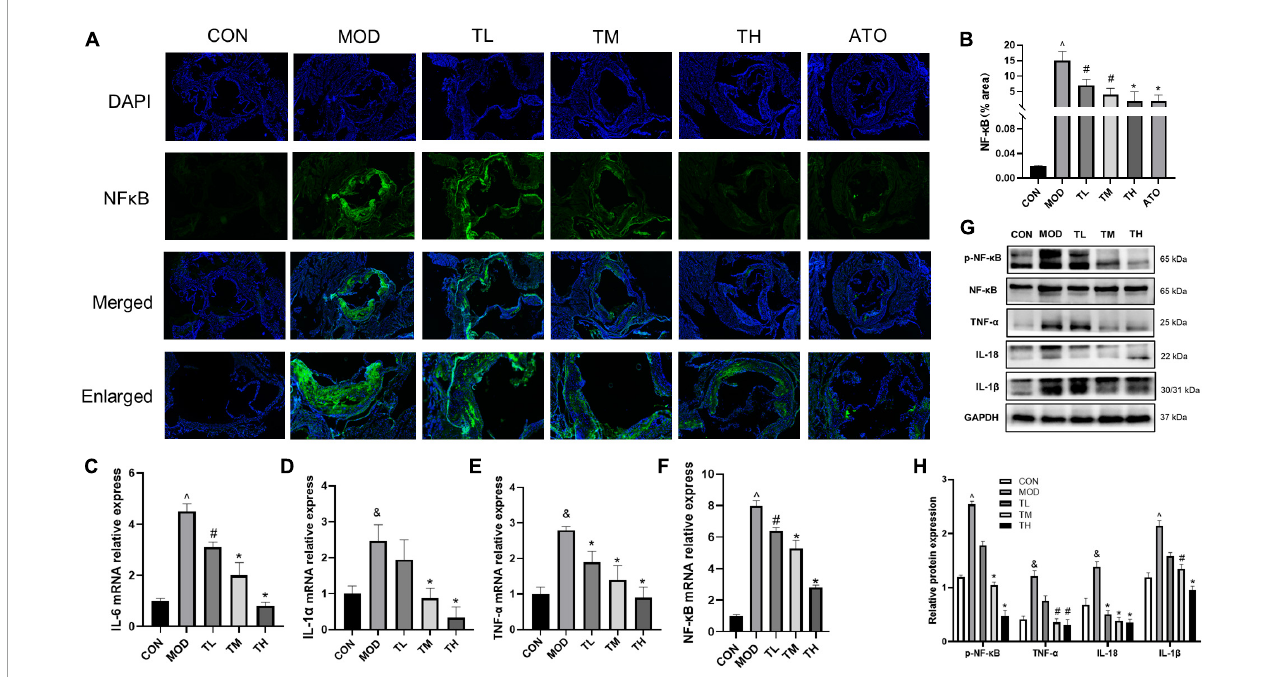
FIGURE10 Effects of THD on inflammatory cytokines in AS Mice. (A) Representative photomicrographs of atherosclerotic plaque stained with NF- κ B in the aortic root. Scale bar = 100 µ m (40 × , Enlarged 200 × ). (B) The NF- κ B fluorescence area and intensity were quantized as a percentage, n = 3. (C–F) Aorta gene expression of IL-6, IL-1 α , TNF- α , and NF- κ B was detected by RT-qPCR, n = 3. (G) Protein expression of NF- κ B, TNF- α , IL-18, and IL-1 β in the aortas was investigated by Western blot. (H) The quantitative results of the western blot were depicted. MOD group was compared to the CON group, and THD was compared with the MOD group. GAPDH was used as an internal reference. Data are expressed as mean ± SEM. & P < 0.05, ∧ P < 0.01 vs. CON group; # P < 0.05, * P < 0.01 vs. MOD group.